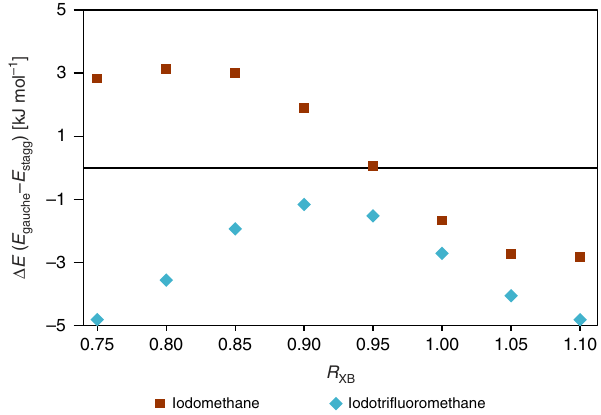
Fig. 5 Calculated energy difference between the staggered and gauche conformations of TMP as a function of the I···N halogen bond length (expressed as R XB ), interacting with either iodomethane (red squares)